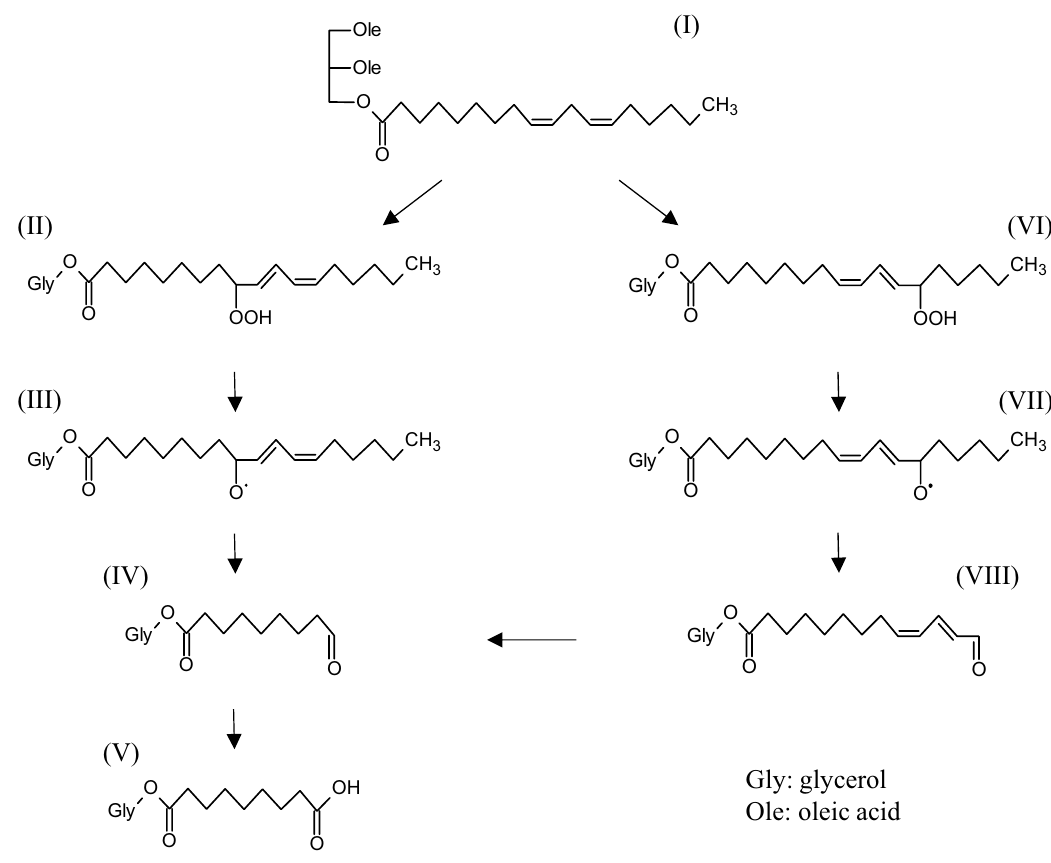
Figure 5. Proposed scheme of the formation of dioleoyl-azelaoyl-glycerol